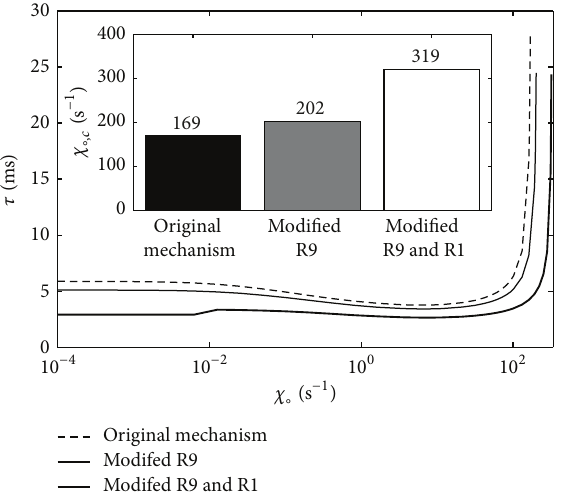
Figure 18: Ignition delay as a function of the peak scalar dissipation rate 𝜒 ∘ obtained using the original and modified mechanisms of Burke et al. [42]. The inset shows the critical values of 𝜒 ∘ above which ignition cannot